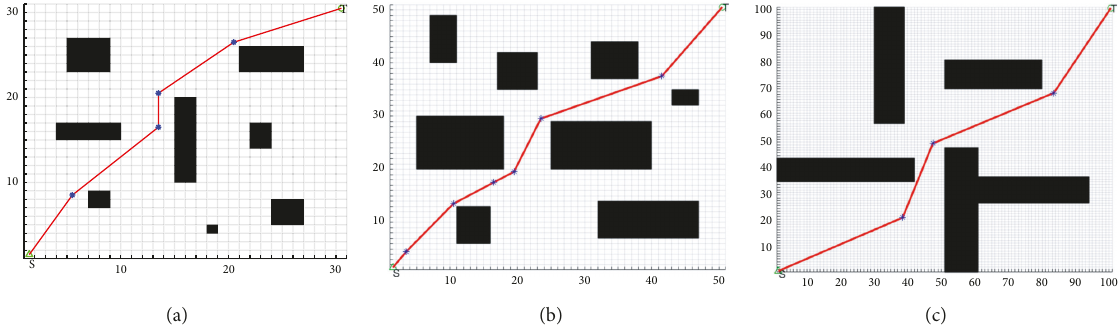
Figure 15: PRM algorithm. (a) 30 ∗ 30. (b) 50 ∗ 50. (c) 100 ∗